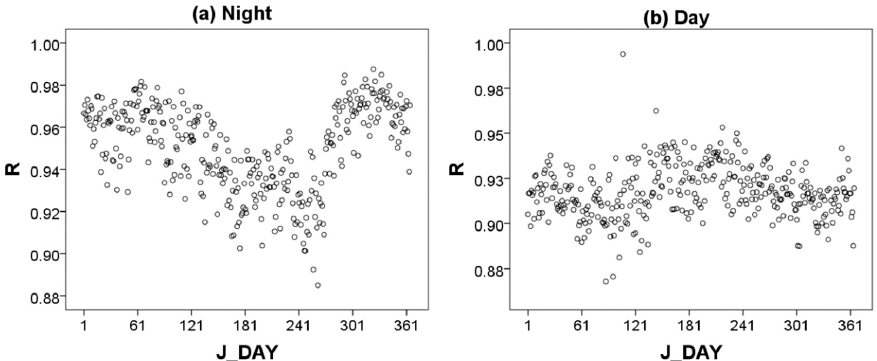
Figure 12. R between the predicted LST and MODIS LST at night and daytime. ( a ) night. ( b ) day.